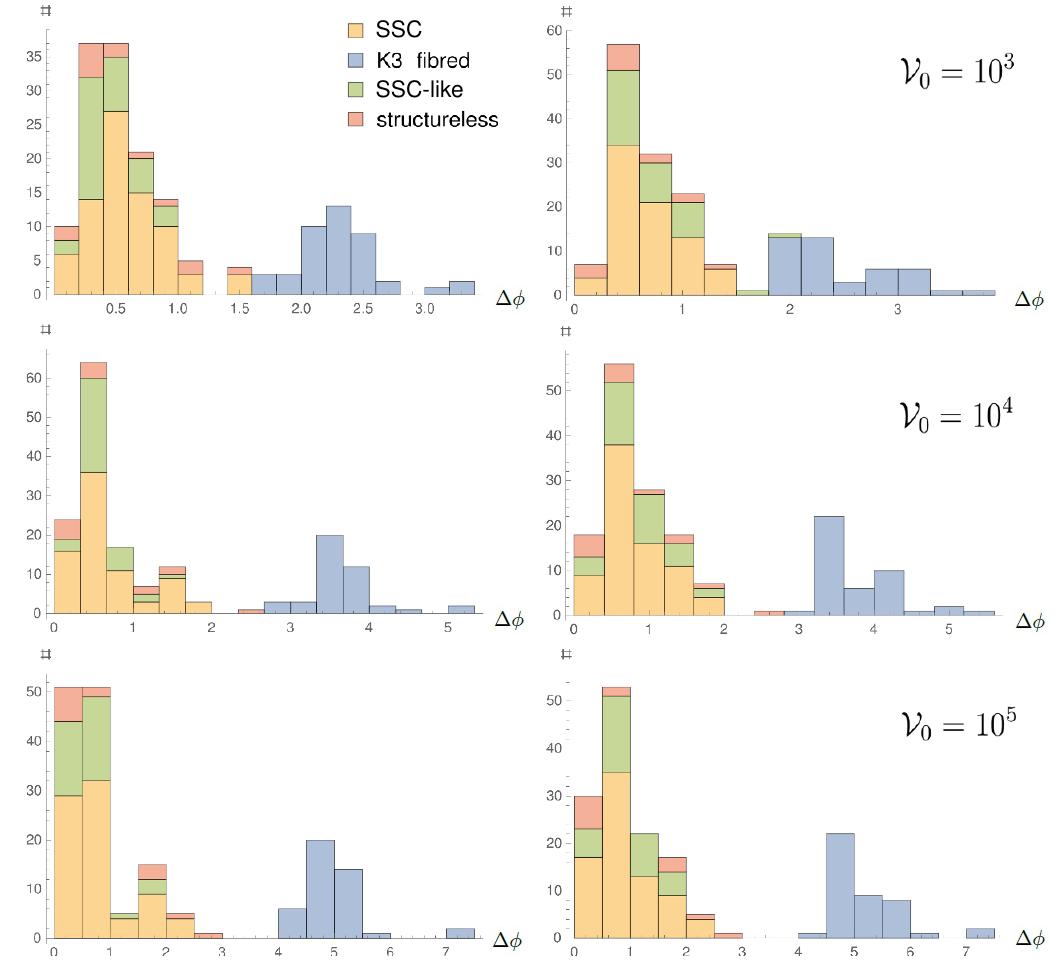
Figure 2 . Distribution of volumes in units of M p of reduced moduli spaces for di(cid:11)erent subclasses of LVS vacua with h 1 ; 1 = 3 for g s = 0 : 1 and V = 10 3 , 10 4 and 10 5 . The histograms on the left 0